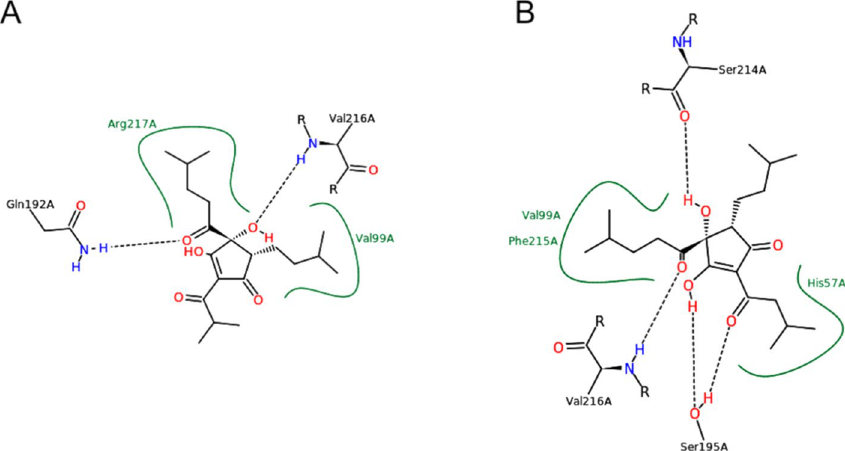
Figure 1. Blind docking of elastase and ( A ) Cis-tetrahydroisocohumulone, ( B ) Cis-tetrahydroisohumulone. ( A ) Shows an incorrect positioning of cis-tetrahydroisocohumulone in the binding site, not being able to interact with the key residues His57, Asp102 nor Ser195, while ( B ) shows the interaction of cis-tetrahydroisohumulone, structurally similar to cis-tetrahydroisocohumulone, bound to the key residues His57 and